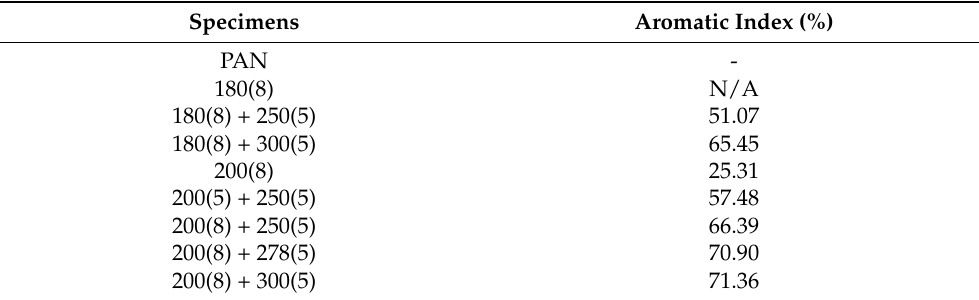
Figure 7. The XRD results of specimens under several two-step processing conditions. Table 1. The aromatic index of specimens under several processing conditions from XRD results.